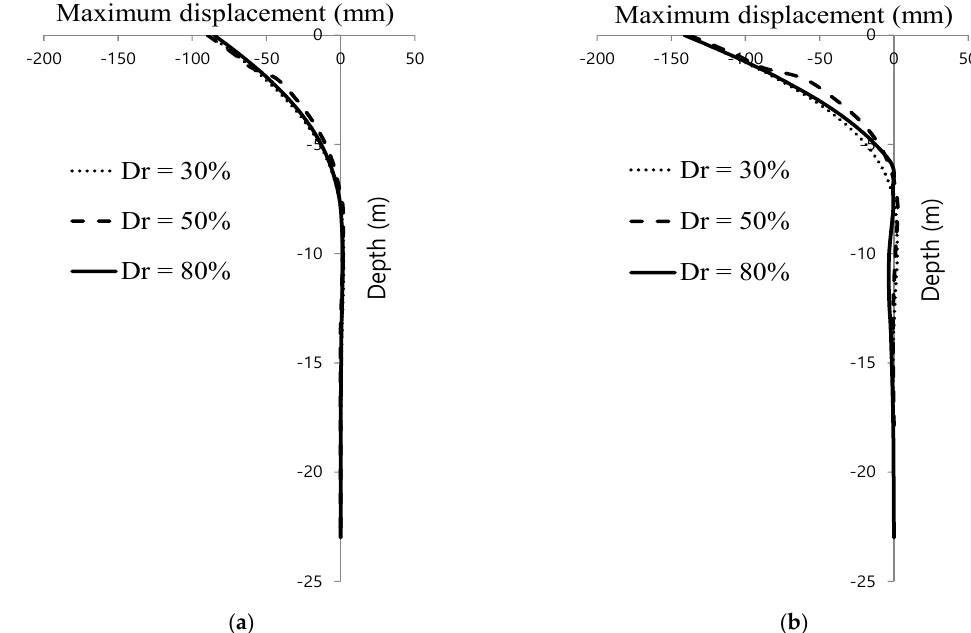
Figure 16. Maximum lateral pile displacement envelopes obtained from three different relative densities. ( a ) Input acceleration: 0.13 g; ( b ) Input acceleration: 0.25 g.